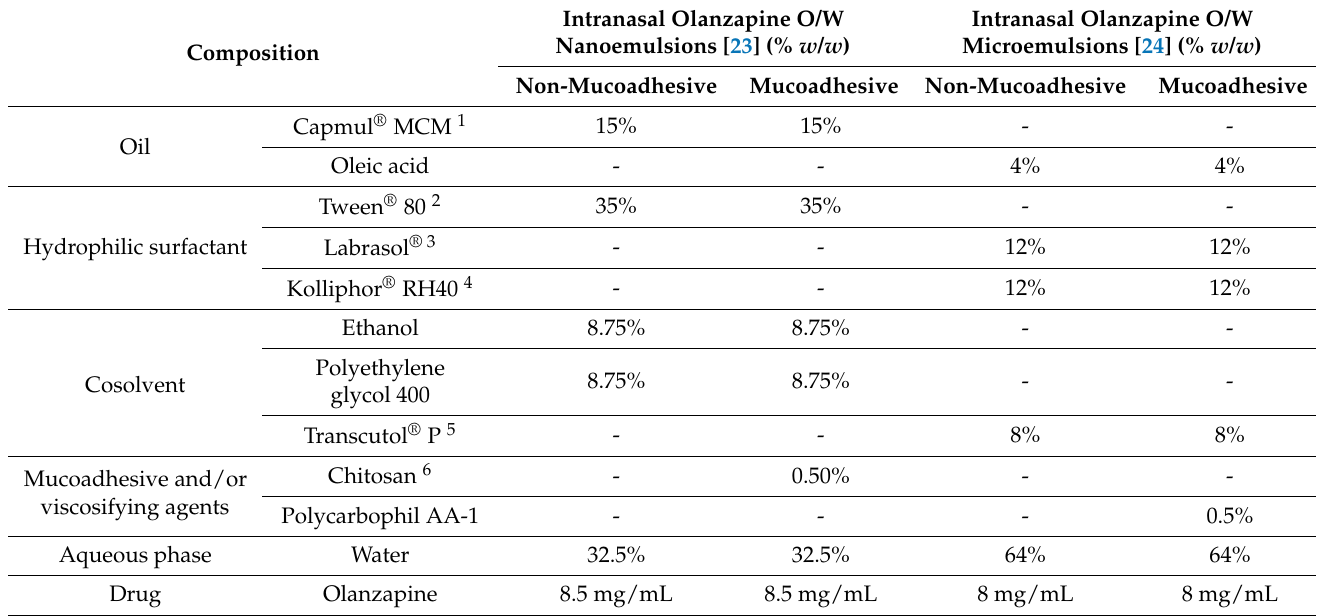
Table 4. Detailed composition of the intranasal olanzapine nano and microemulsions. Excipient and drug quantities and units are shown as reported in the respective articles ( w / w % for excipients, and mg/mL for drugs). For the excipients the brand name was used (when available). Intranasal Olanzapine Composition